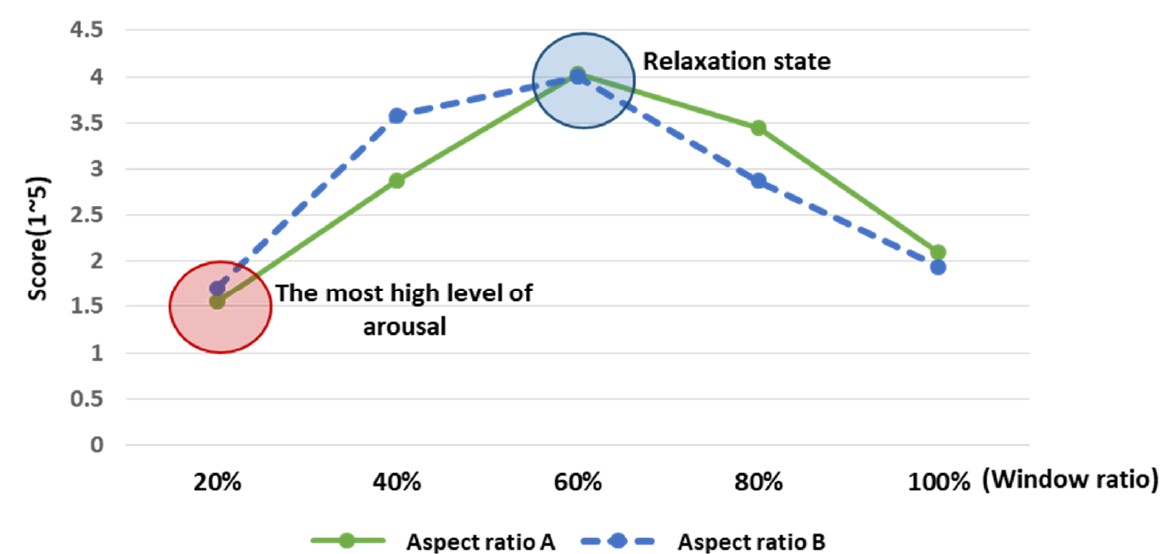
Figure 9. Analysis of relaxation-arousal levels for window ratio by aspect ratio. An average of four points or more were felt relaxed in the corresponding element. The window ratio, shown in the relaxation state, was marked with a blue circle, while the window ratio, shown in the highest arousal state, was marked with a red circle.